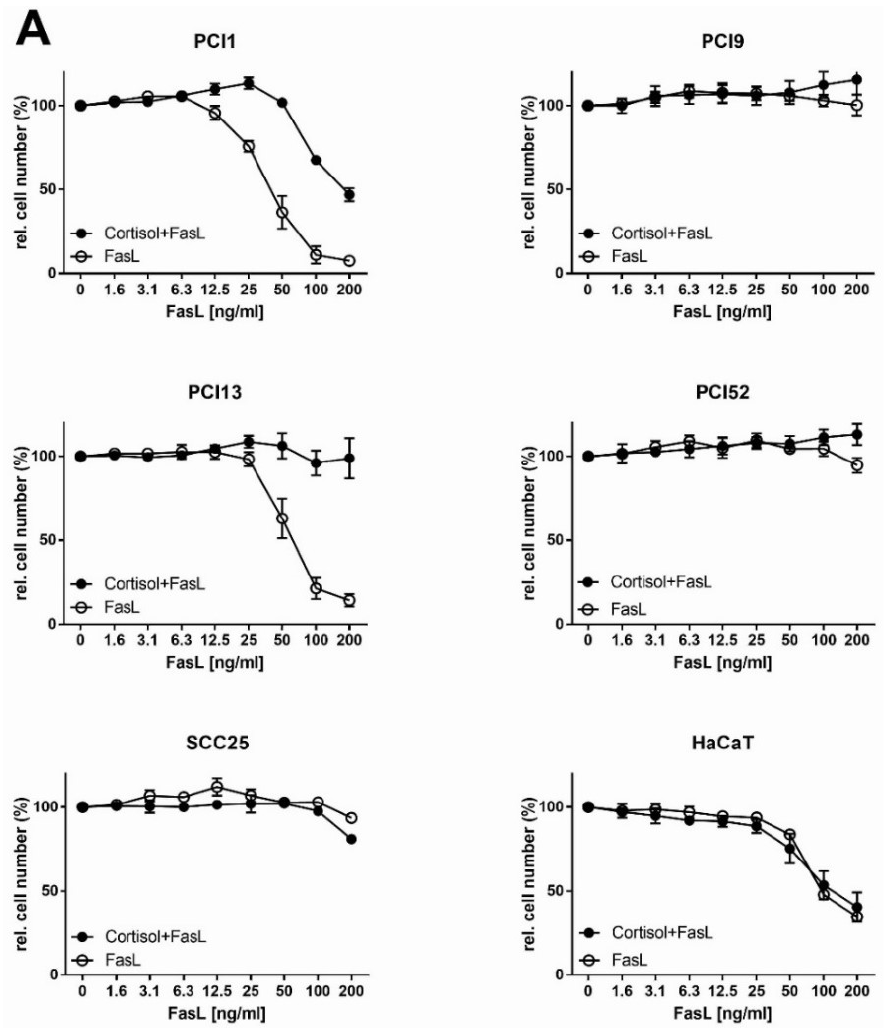
Figure 5. Cont Figure 5. Cont.